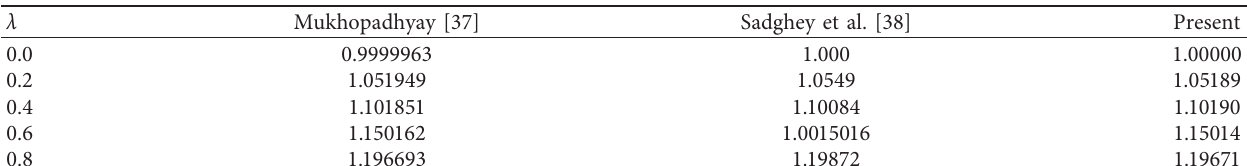
Table 2: Code validation results with f ″ ( 0 ) obtained by Mukhopadhyay [37] and Sadghey et al. [38] in the limiting condition for various λ by fixing M � 0